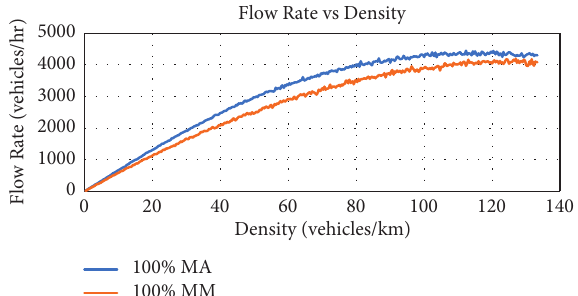
Figure 18: Flow rate vs. density fundamental diagrams for different compositions of 100 percent MA vs. 100 percent MM.